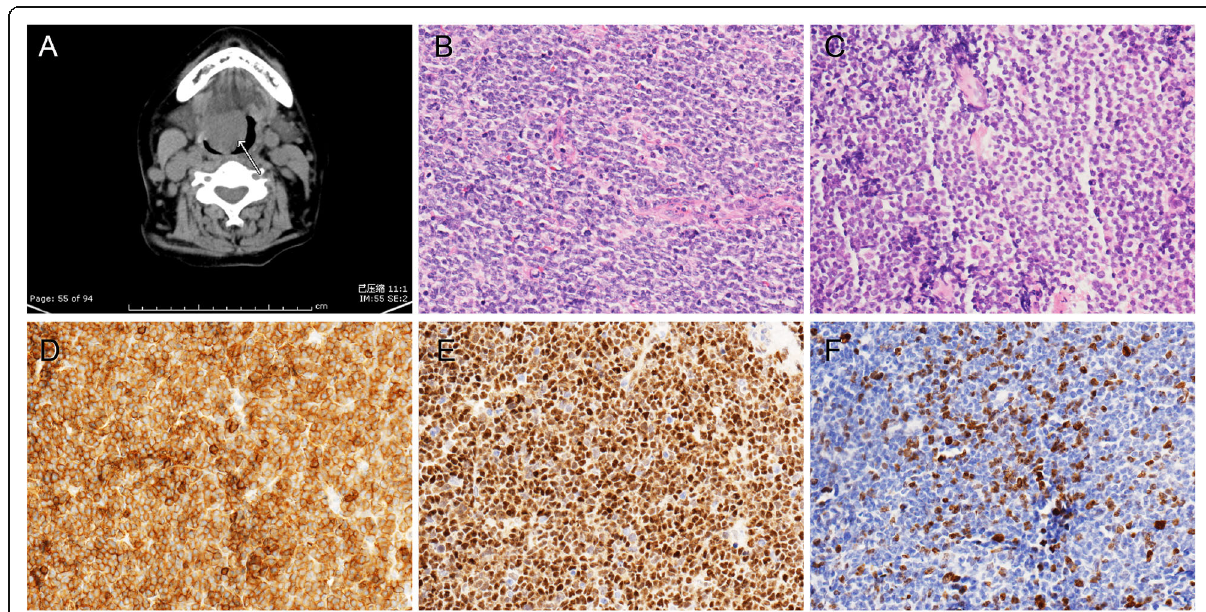
Fig. 4 Imaging and pathological findings of MCL (case 2). a . CT showed an irregular soft tissue mass at the right posterior aspect of the tongue base. b . Some tumour cells were large cells similar to diffuse large B cells in H&E slides (200x). c . Some tumour cells were medium-sized with a clear cytoplasm (200x). d . Tumour cells were positive for CD5 (200x). e . Tumour cells were positive for Cyclin D1 (200x). f . Ki-67 staining of